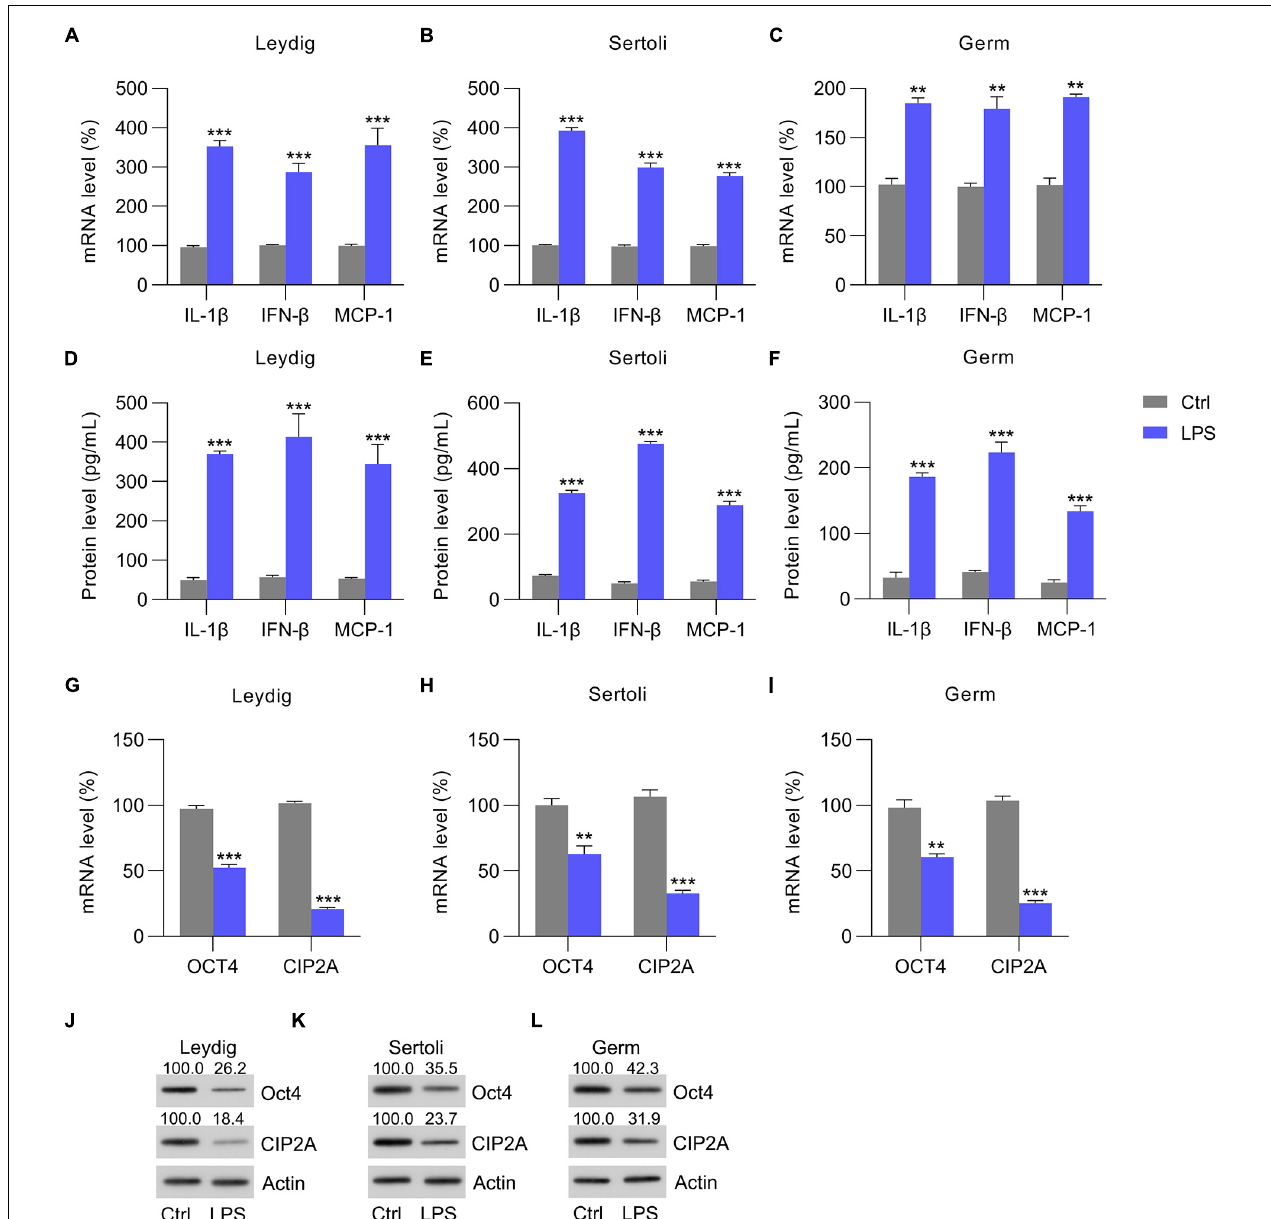
FIGURE 2 | LPS-induced cytokine expression. Sertoli, germ, and Leydig cells isolated from C57BL/6 mice were incubated with LPS or PBS for 12 h. (A–C) Total RNA was extracted to determine the relative mRNA expression of IL-1 β , IFN- β , and MCP-1 in cells with RT-qPCR. (D–F) ELISA was conducted to detect secreted IL-1 β , IFN- β , and MCP-1 levels. (G–I) The mRNA and (J–L) protein levels of OCT4 and CIP2A in testicular homogenate were revealed by RT-qPCR and WB, respectively. Data are expressed as the means ± SDs. ** P < 0.01, *** P < 0.001, Ctrl vs. LPS.